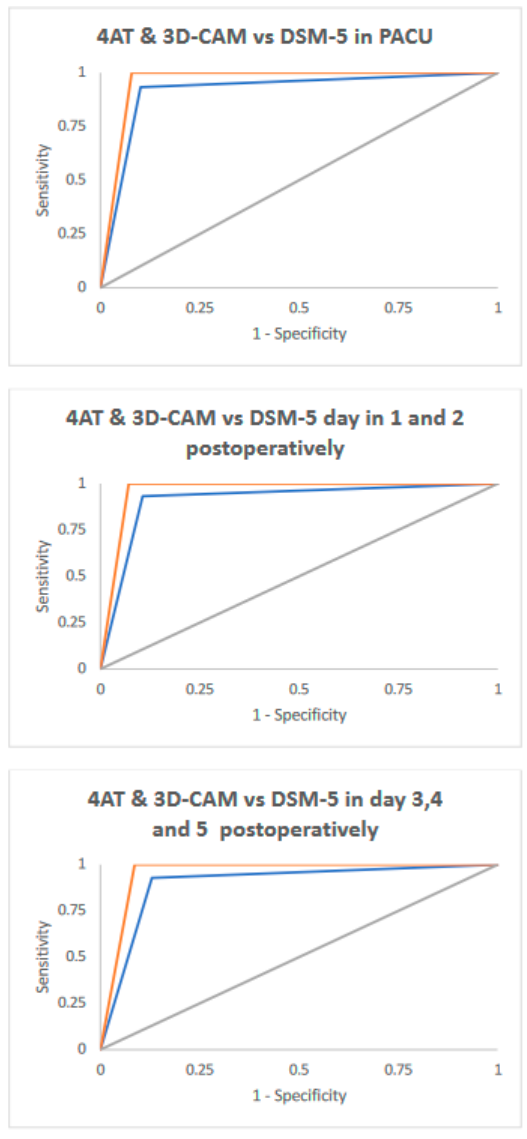
Figure 2. Receiver operation characteristic curve of the 4AT (blue curve) and the 3D-CAM (orange curve) compared with the reference standard (DSM-5).